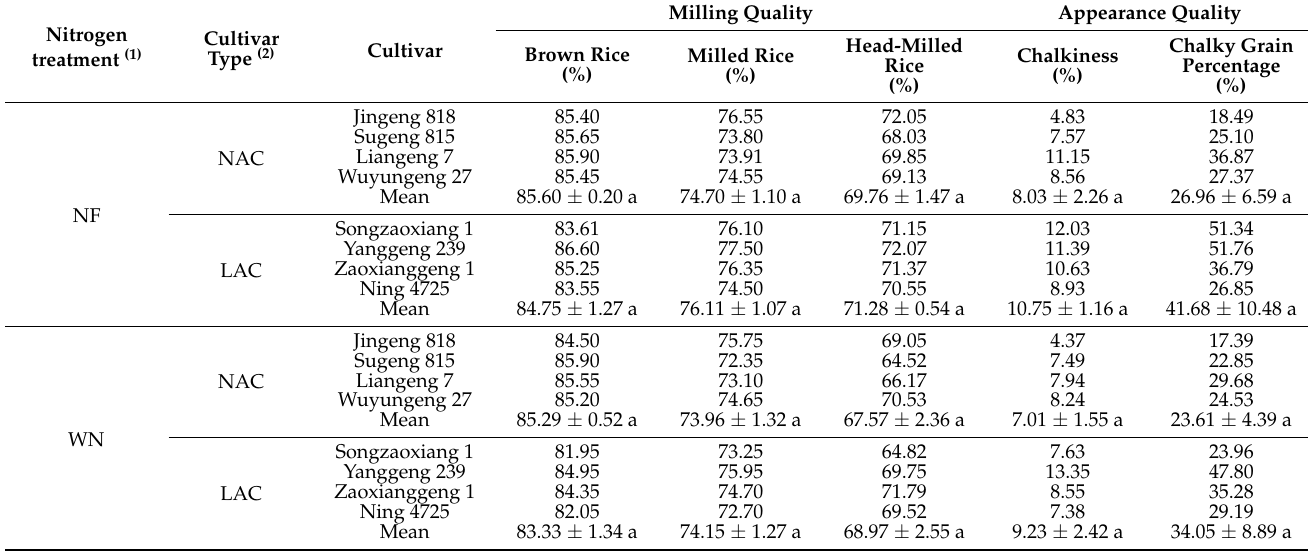
Table 3. Milling and appearance quality of japonica rice cultivars with different contents of amylose, grown with or without nitrogen